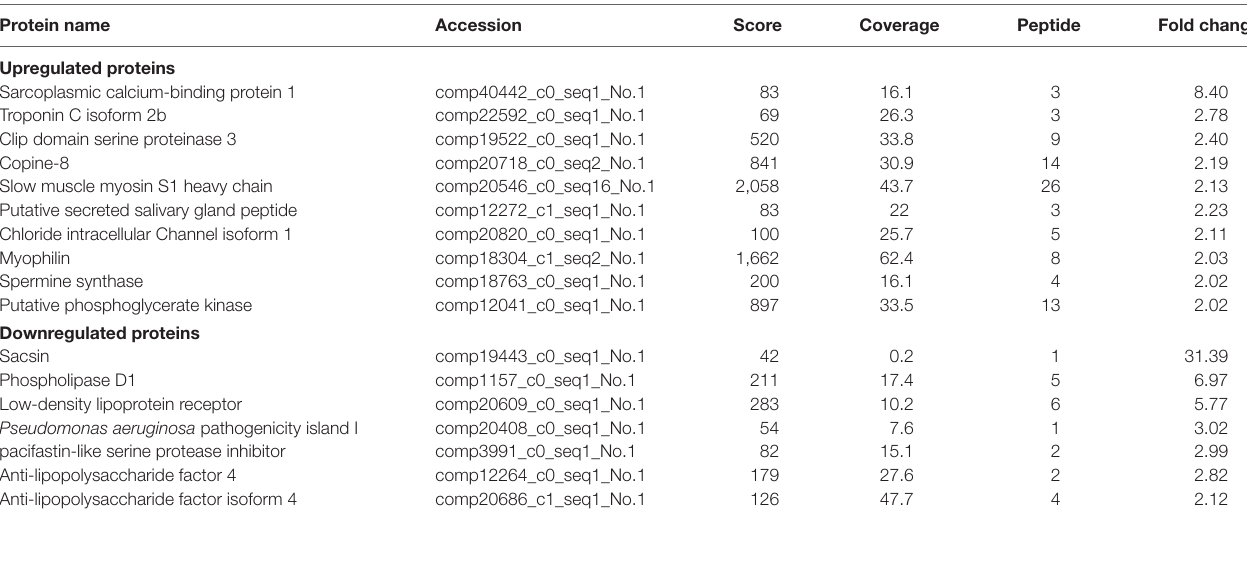
TaBle 2 | The differential expressed proteins in Scylla paramamosain hemocytes with above two-fold change post injection with V. anguillarum . Protein